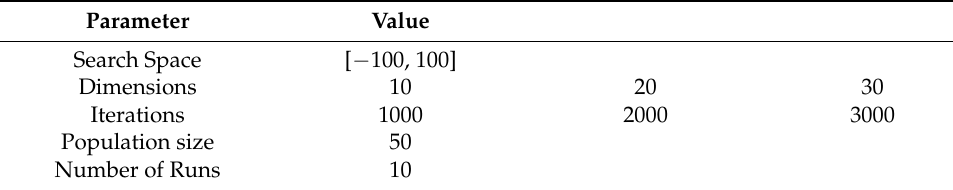
Table 1. Experimental setting of parameters.